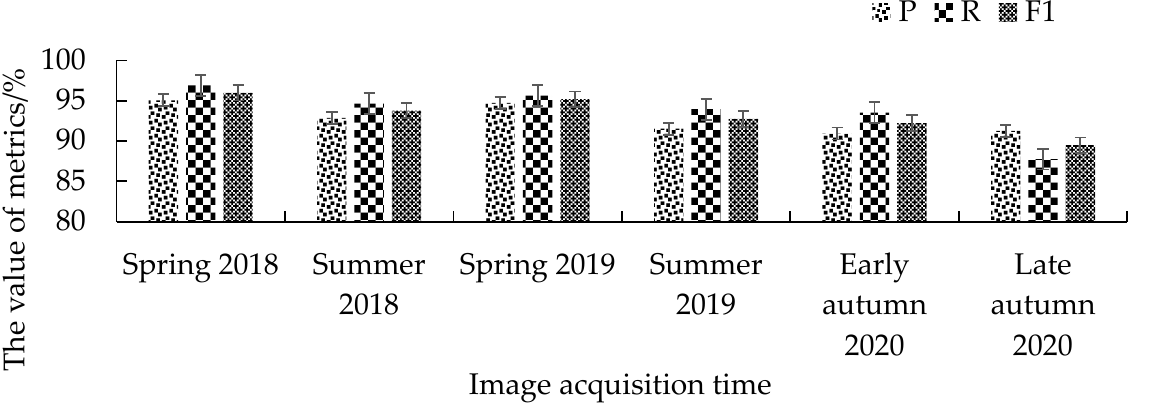
Figure 13. Average statistics of the proposed method for 200 sample images.